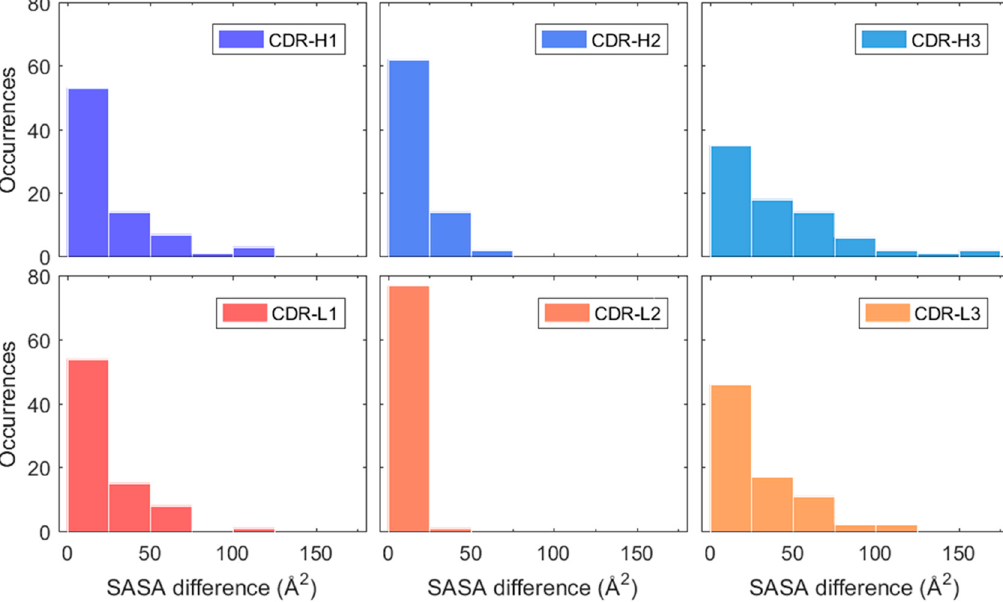
Figure 6. Estimated absolute SASA difference of H1, H2, H3, L1, L2, and L3 between simulation averages of 0–5 and 5–50 ns. The heavy chain CDR loops (H1, H2, and H3) are highlighted in blue and light chain CDR loops (L1, L2, and L3) in red-orange.